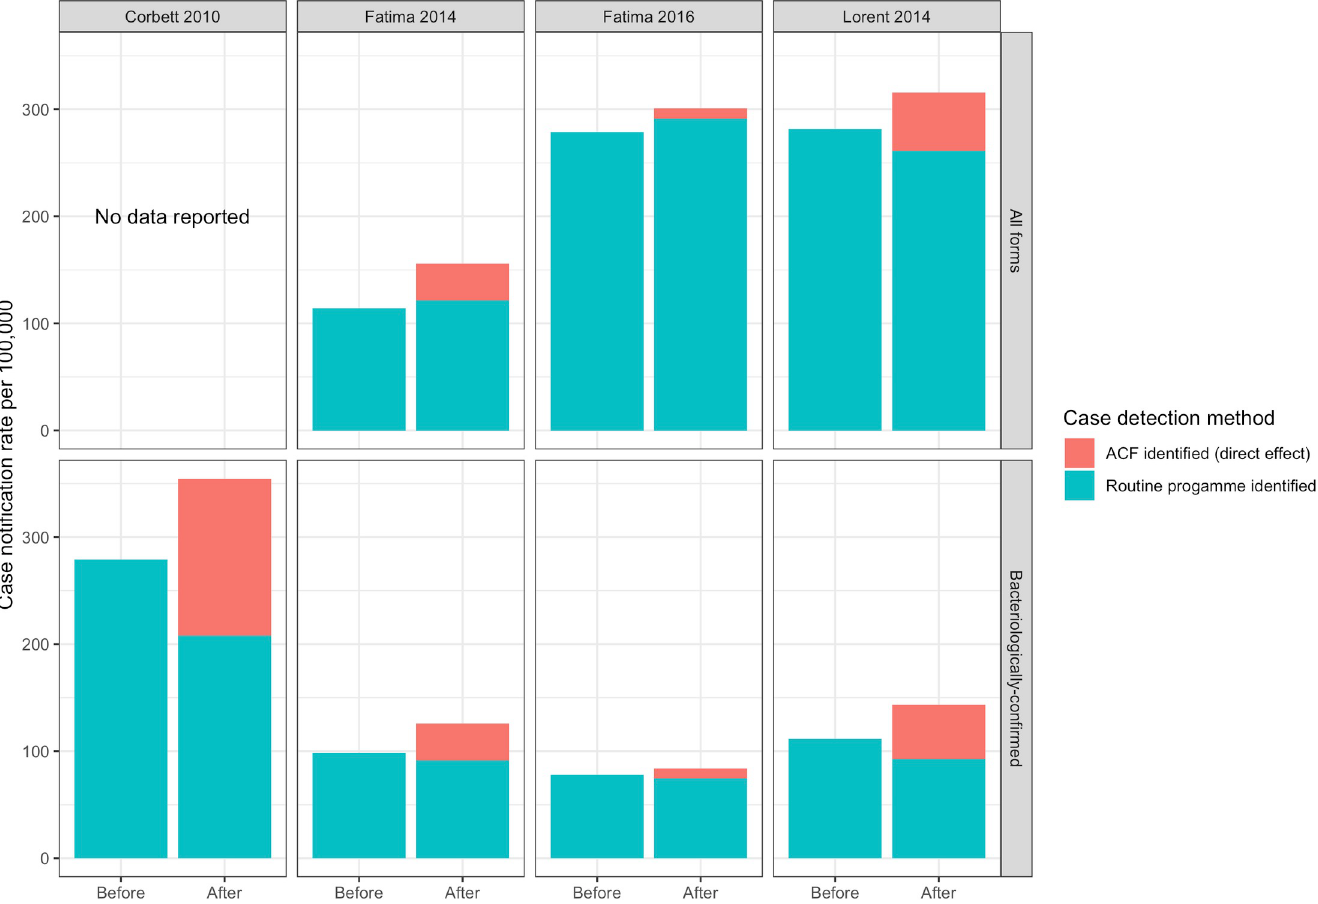
Fig 4. Routinely diagnosed case notification rates in non-randomised before-after studies.